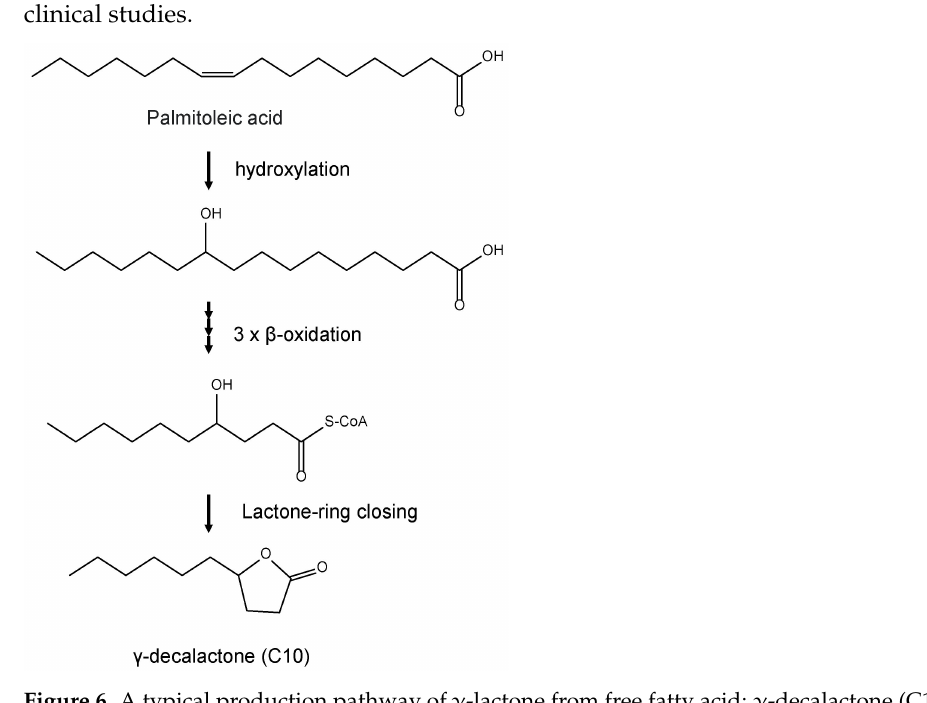
Figure 6. A typical production pathway of γ -lactone from free fatty acid: γ -decalactone (C10) from palmitoleic acid with 3 steps of β